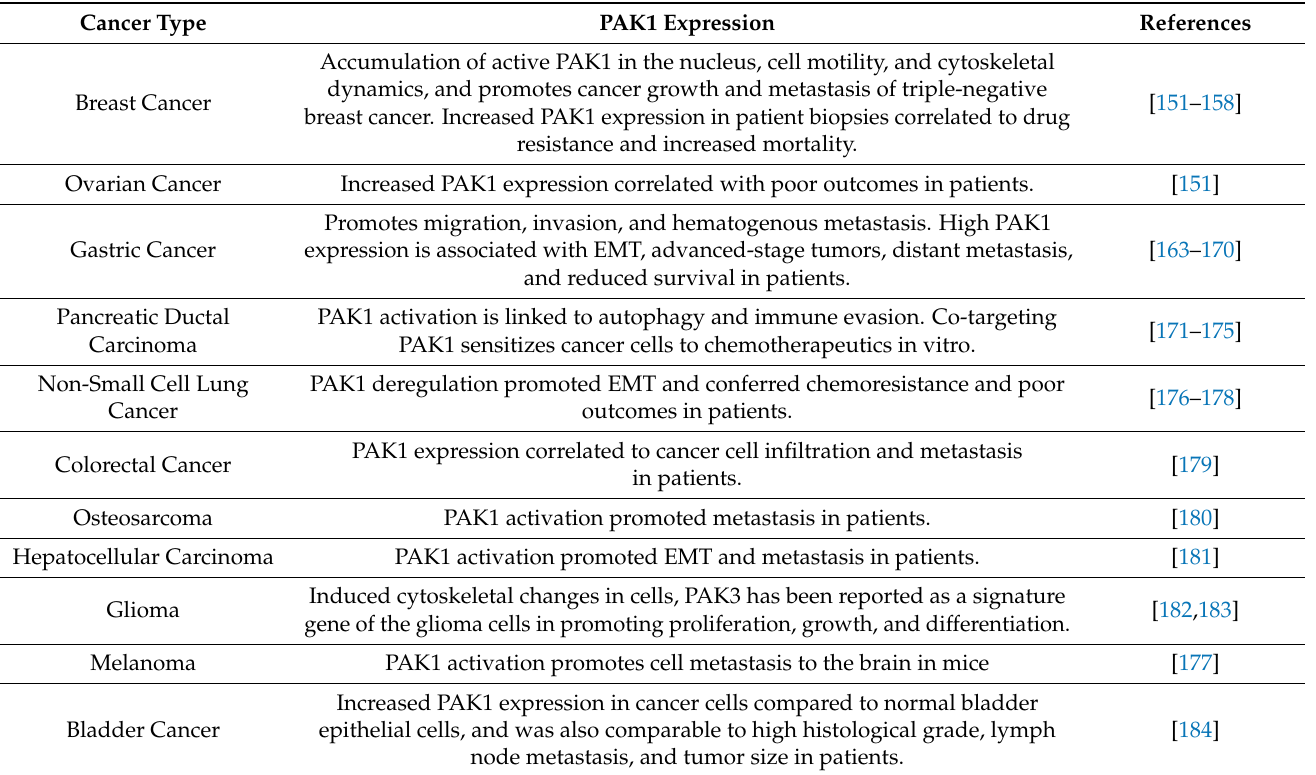
Table 1. PAK1 expression in various